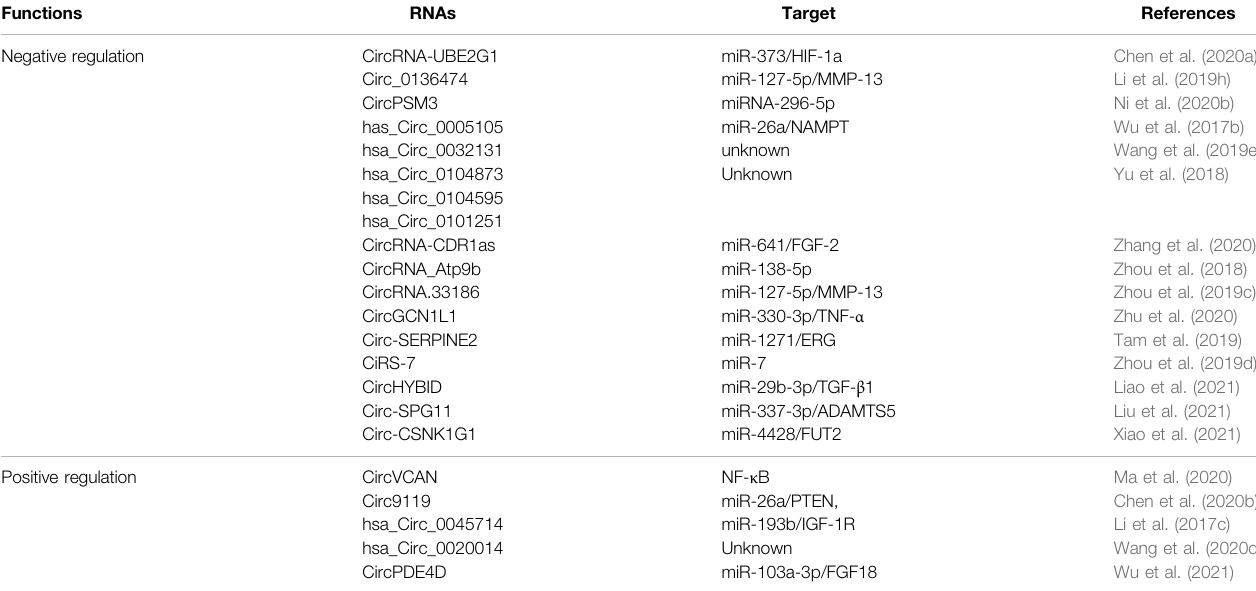
TABLE 3 | CircRNAs and the targets in